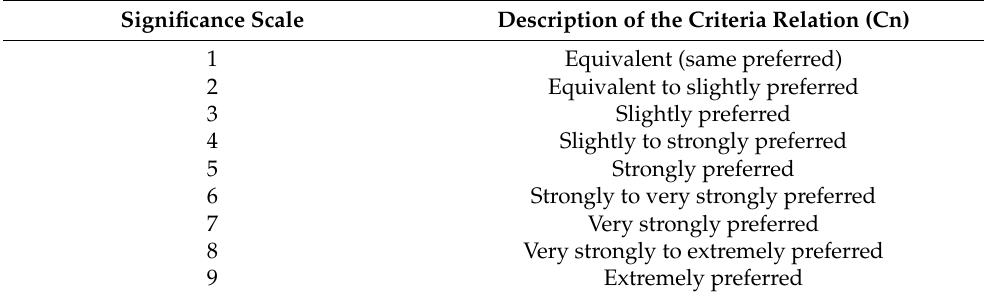
Table 1. Saaty’s universal comparison